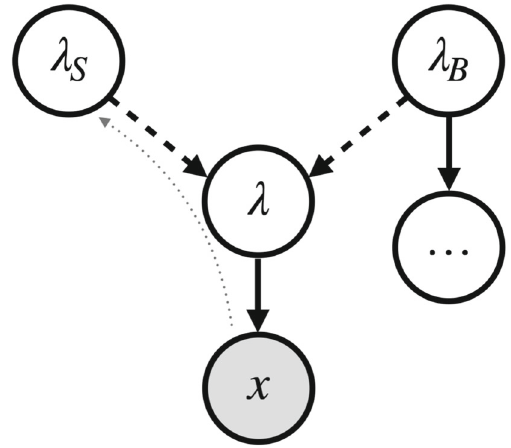
Fig. 1 Bayesian network for a Poisson process with intensity λ and observednumberofevents x .Theintensity λ isinturnthesumofasignal contribution λ S and a background contribution λ B , and thus the links connecting λ S and λ B to λ are deterministic. The dots denote a possible additional portion of the network representing previous measurements, e.g. during calibration, of λ B . The inferential process is an information flow (gray dotted arrow) from the observed node x , denoted in gray, to the parameter of interest λ